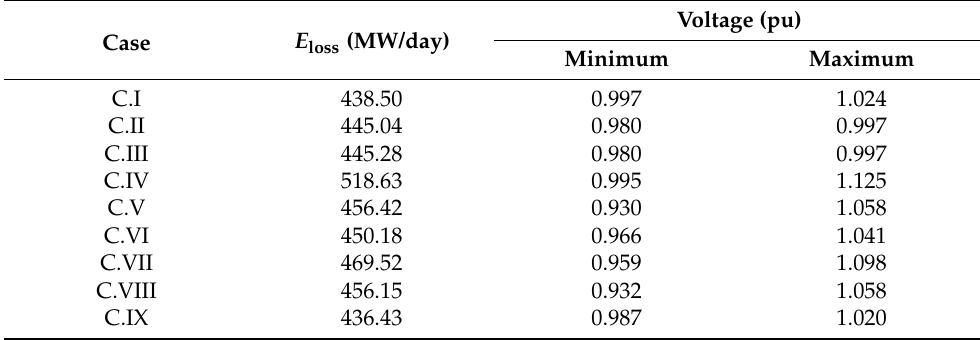
Table 3. Daily energy losses and voltage resulting by implementing different reactive power control